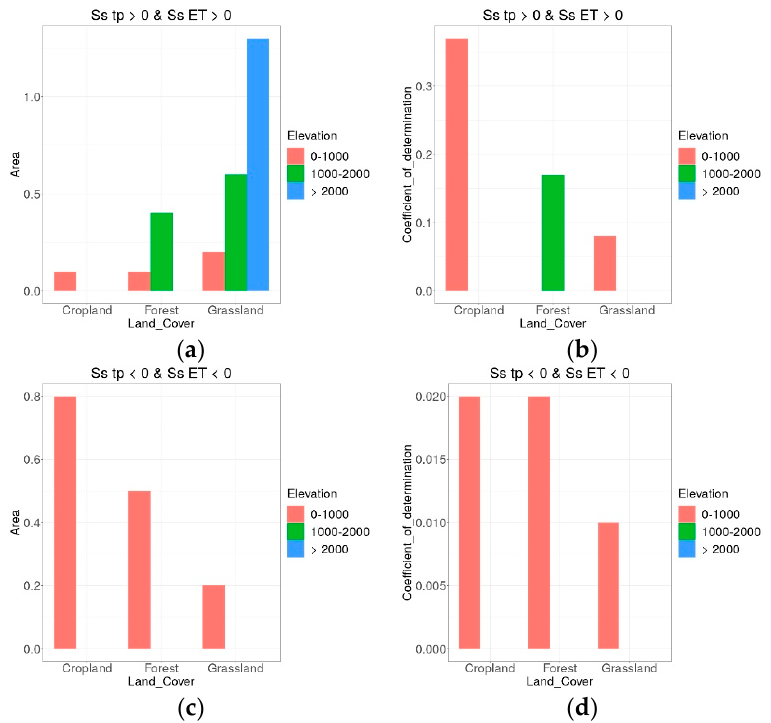
Figure 17. Percentage of area in each land cover class where tp and SSEBop ET trends overlap, per elevation ( a , c ) and corresponding r 2 ( b , d ). The combination of positive or negative ET and tp trends is indicated in the title of each plot. “Area” on the y axis is the percentage of the total area within each land cover class. Ss is the Sen’s slope of the trend at 5% significance from 2003 to 2019.